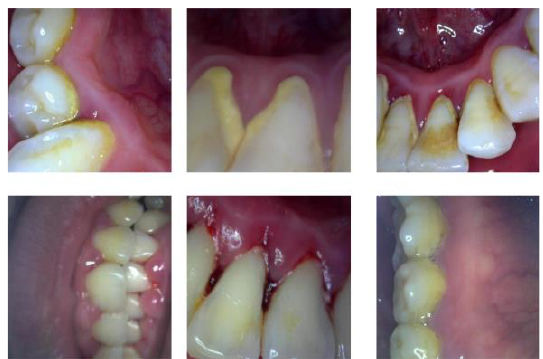
Figure 7. Example of combined dataset.